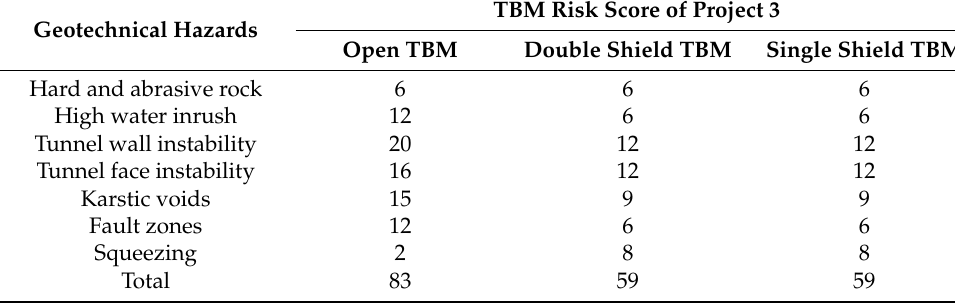
Table 24. TBM risk score of Project